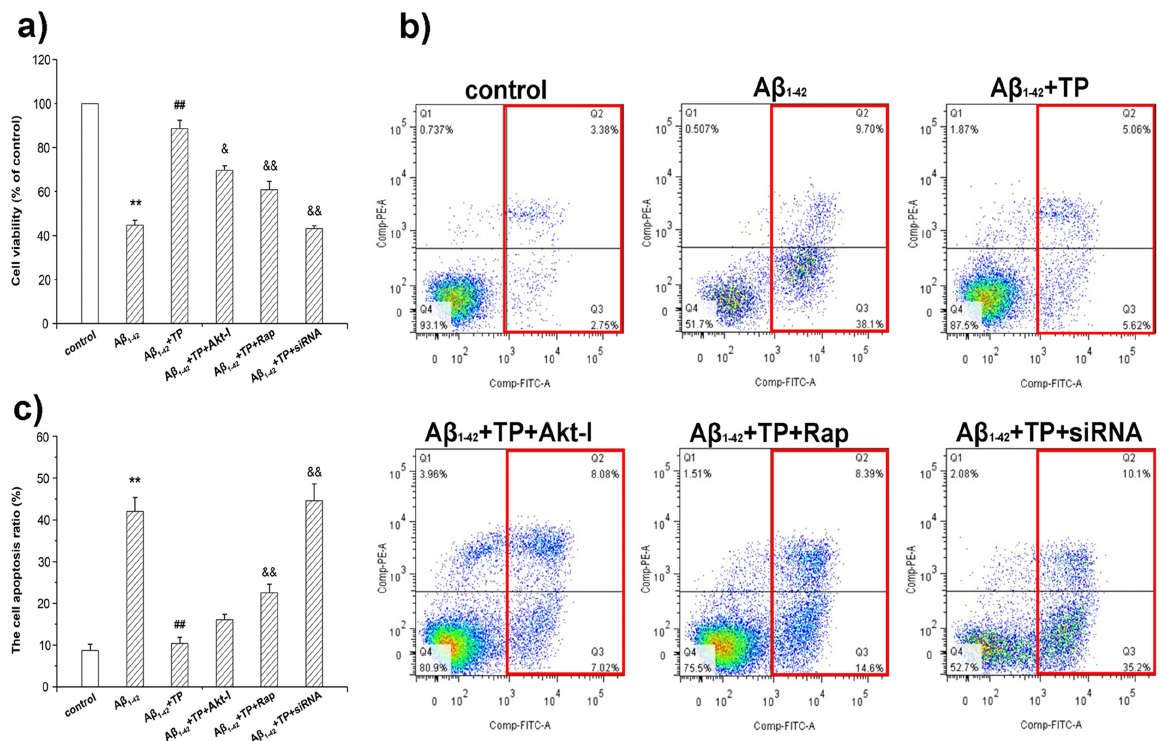
Figure 9. Effect of the Akt/mTOR/p70S6K pathway during the neuroprotection of triptolide. (a) was cell viability with CCK-8 assay. Data represent the mean ± S.E.M. n=6/group. (b) was flow cytometric analysis of apoptosis. The intensity of Annexin V-FITC fluorescence was on the X-axis and PI fluorescence was on the Y-axis. (c) was the corresponding linear diagram of flow cytometric analysis. Data represent the mean ± S.E.M. Flow cytometric assay was performed three times. A medium of cell culture (10 μmol/L Aβ +10 -9 mol/L triptolide, 10 μmol/L 1-42 Aβ , 10 μmol/L Aβ +10 -9 mol/L triptolide+ 15 μmol/L Akt-I-1/2, 10 μmol/L Aβ +10 -9 mol/L triptolide+ 10ng/ 1-42 1-42 1-42 ml rapamycin, 10 μmol/L Aβ +10 -9 mol/L triptolide+ siRNA-mTOR) were incubated for 24 h. ** P < 0.01 vs. 1-42